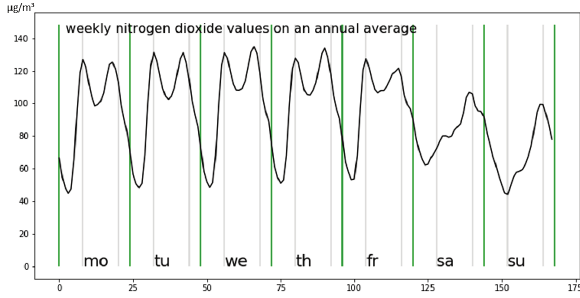
Figure 4: Weekly NO 2 values (µg/m³) on an annual average for the station “Stuttgart Am Neckartor” (2003 to 2019).